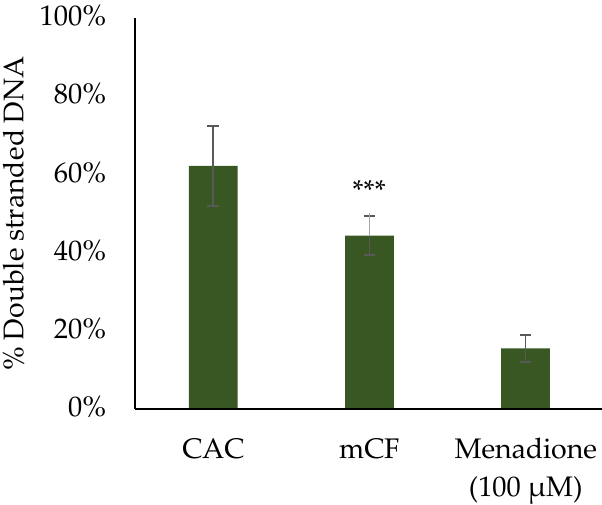
Figure 9. Assessment of DNA strand breaks after exposure of BEAS-2B/dTHP-1/CCD-33Lu triple- cultures to mechanically treated carbon fibers (mCF). CCD-33Lu cells were seeded on inverted inserts with a density of 9 × 10 4 /cm 2 . After 1 h, the inserts were inverted, and BEAS-2B cells were seeded with a density of 2 × 10 5 /cm 2 . After 4 h, dTHP-1 cells (3.9 × 10 4 /cm 2 ) were seeded on top of the BEAS-2B cells. On the next day, mono- and co-culture were exposed to an average surface dose of 7.00 ± 1.25 µg/cm 2 mCF for 1 h and post-incubated for 24 h. Clean air controls (CAC) received equivalent treatment. Positive control cultures were exposed to 100 µM menadione 1 h prior to the end of the experiment. The mean values ± SD of three independent experiments performed in duplicates are displayed. Statistical analysis was performed to assess differences between untreated and treated cells using Student’s t -test: *** ( p ≤ 0.001).